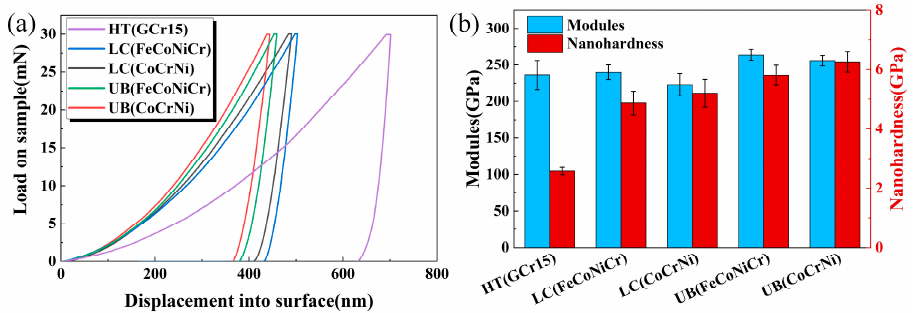
Figure 10. Nano-indentation test results. ( a ) Load–displacement curves; ( b ) elastic moduli and nano-hardness values.